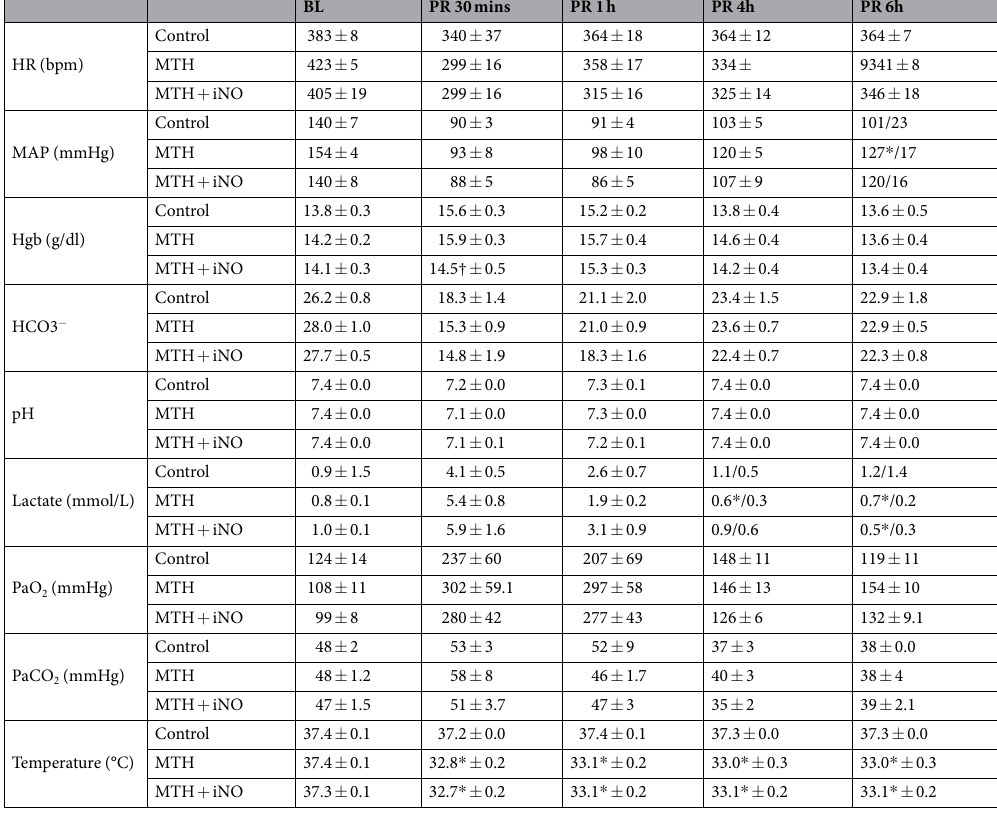
Table 1. Physiologic data. Physiologic data for control, MTH and MTH + iNO treated animals at baseline and after cardiopulmonary resuscitation. Temperature indicates body temperature measured using an oesophageal probe. * p < 0.05 vs. control, † p < 0.05 vs. MTH; mean ± SEM, except not normally distributed Lactate at PR 4h and PR 6h and MAP at PR 6h. HR heart rate, MAP mean arterial pressure, Hgb haemoglobin, HCO3